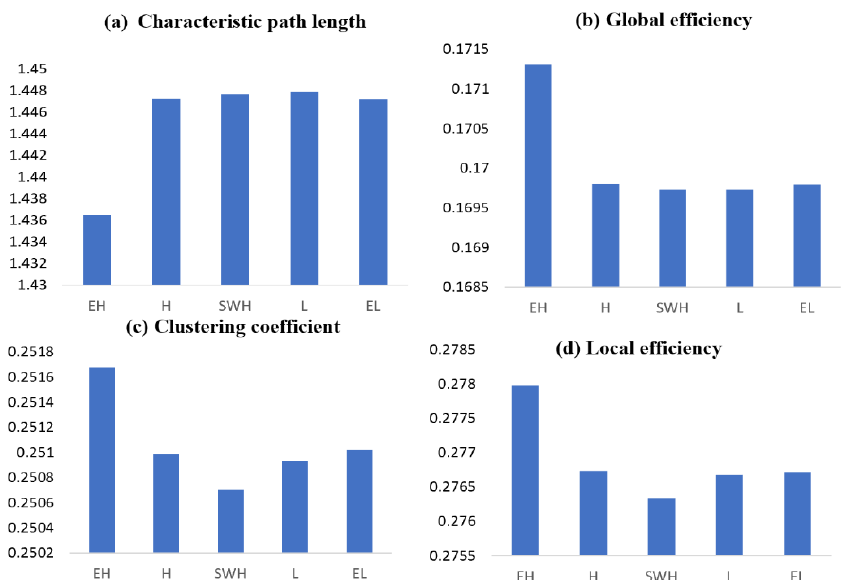
Figure 13. Graph theoretical network metrics showing the main effects of different exertion levels. ( a ) Characteristic path length. ( b ) Global efficiency. ( c ) Clustering coefficient. ( d ) Local efficiency for alpha coherence. EL: extremely light, L: light, SWH: somewhat hard, H: hard, and EH: extremely hard.